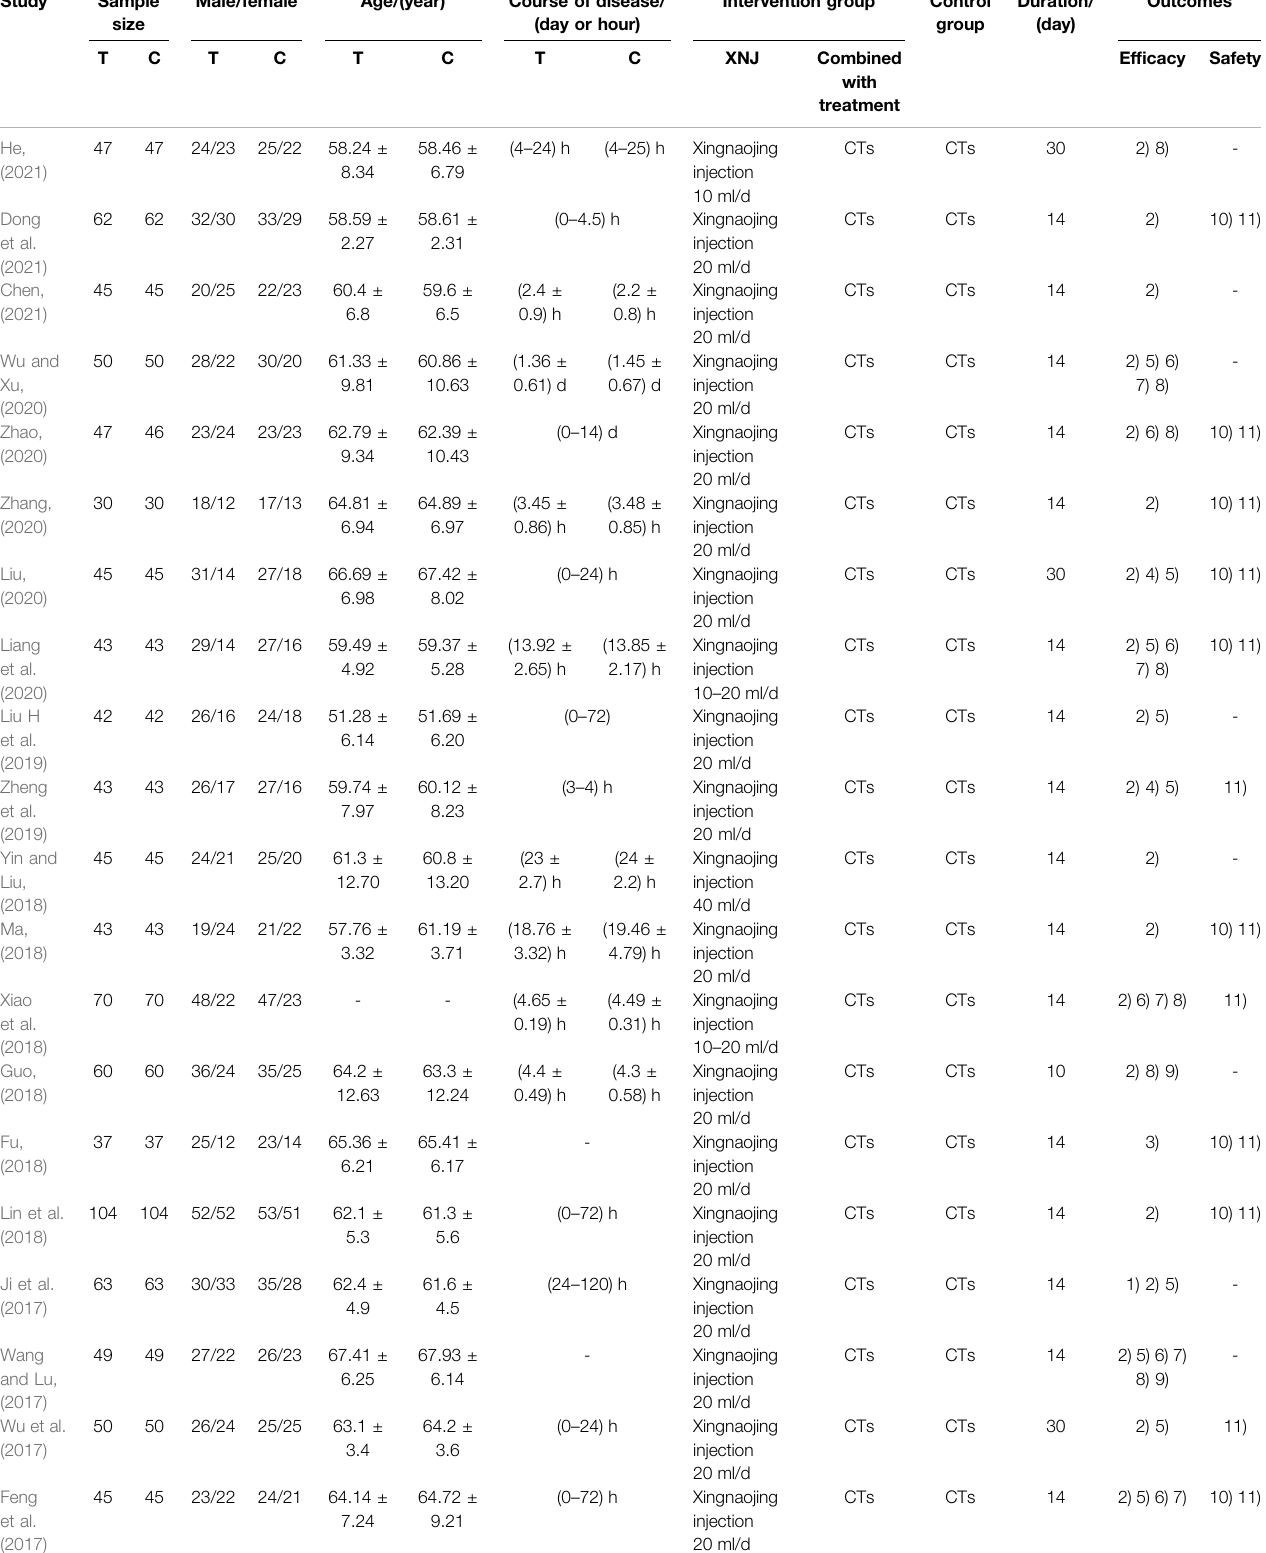
TABLE 1 | Basic characteristics of the included